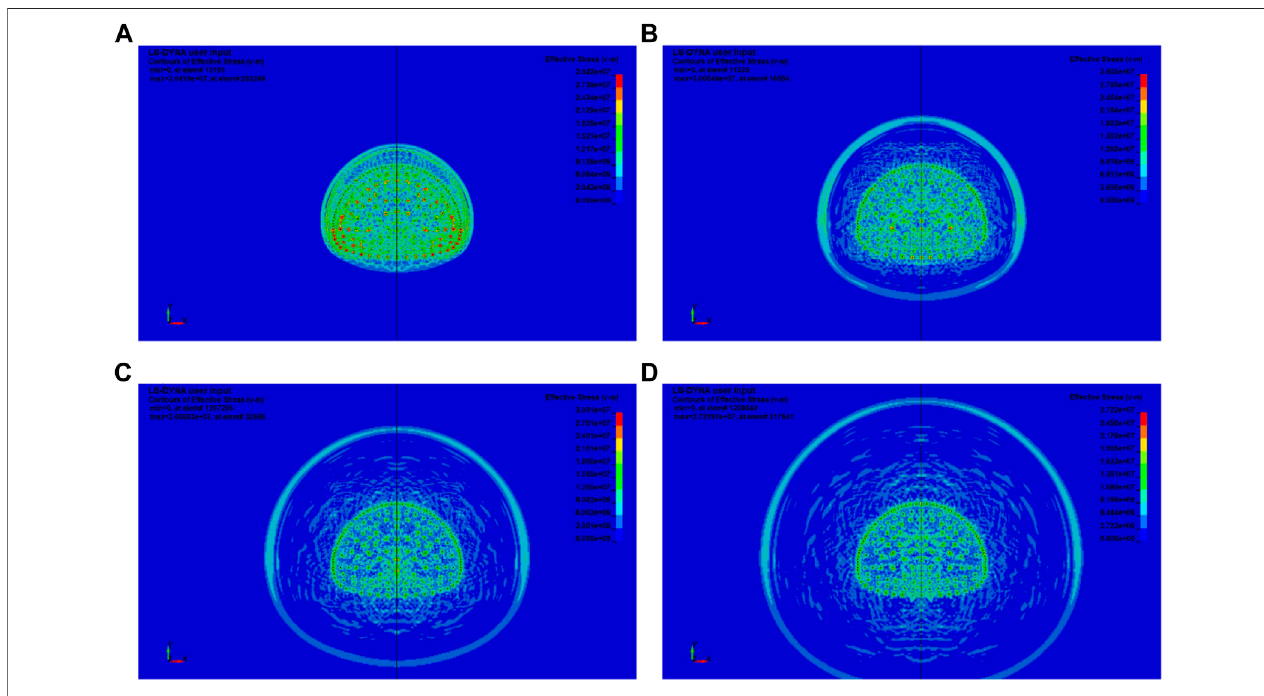
FIGURE 5 | Stress wave propagation and attenuation. (A) detonate each section of explosive; (B) the stress wave propagates outward in the radial direction; (C) the stress wave begins to decay; (D) the stress wave attenuates continuously until it becomes a seismic wave.